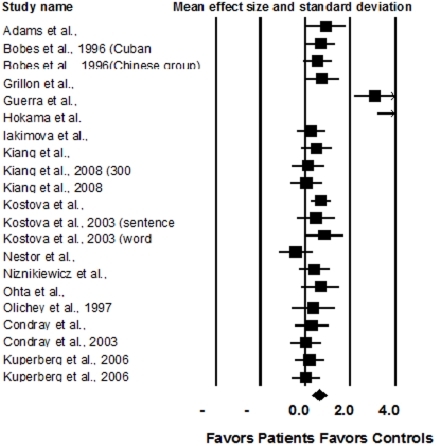
Comparison of the N400 effect between schizophrenia and controls.